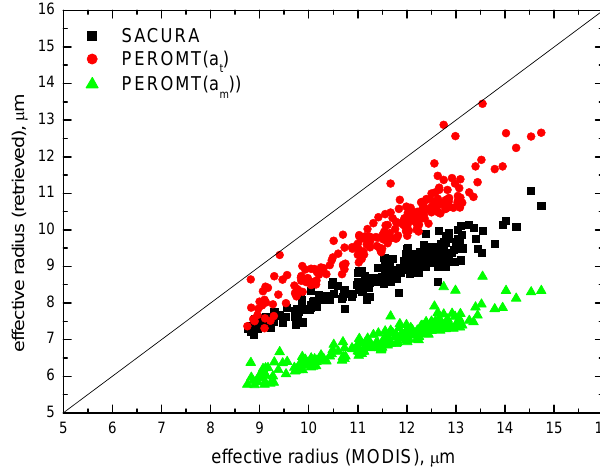
Fig. 7a. The correlation between COT derived using MODIS algorithm and SACURA, PEROMT retrievals. Fig. 7b. The same as in Fig. 7a except for the effective radius.